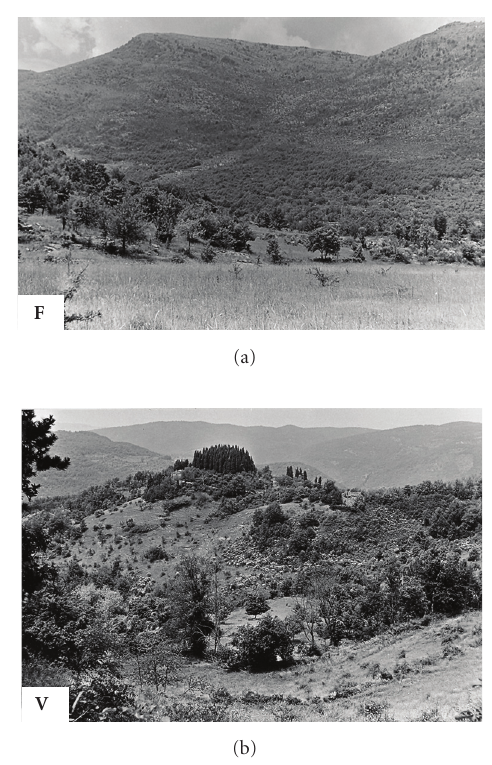
Figure 3: Natural focus of Bhanja virus infections in central Italy (Fondi-Campodimele, F ) and northern central Italy (Toscana- Vaglia, V